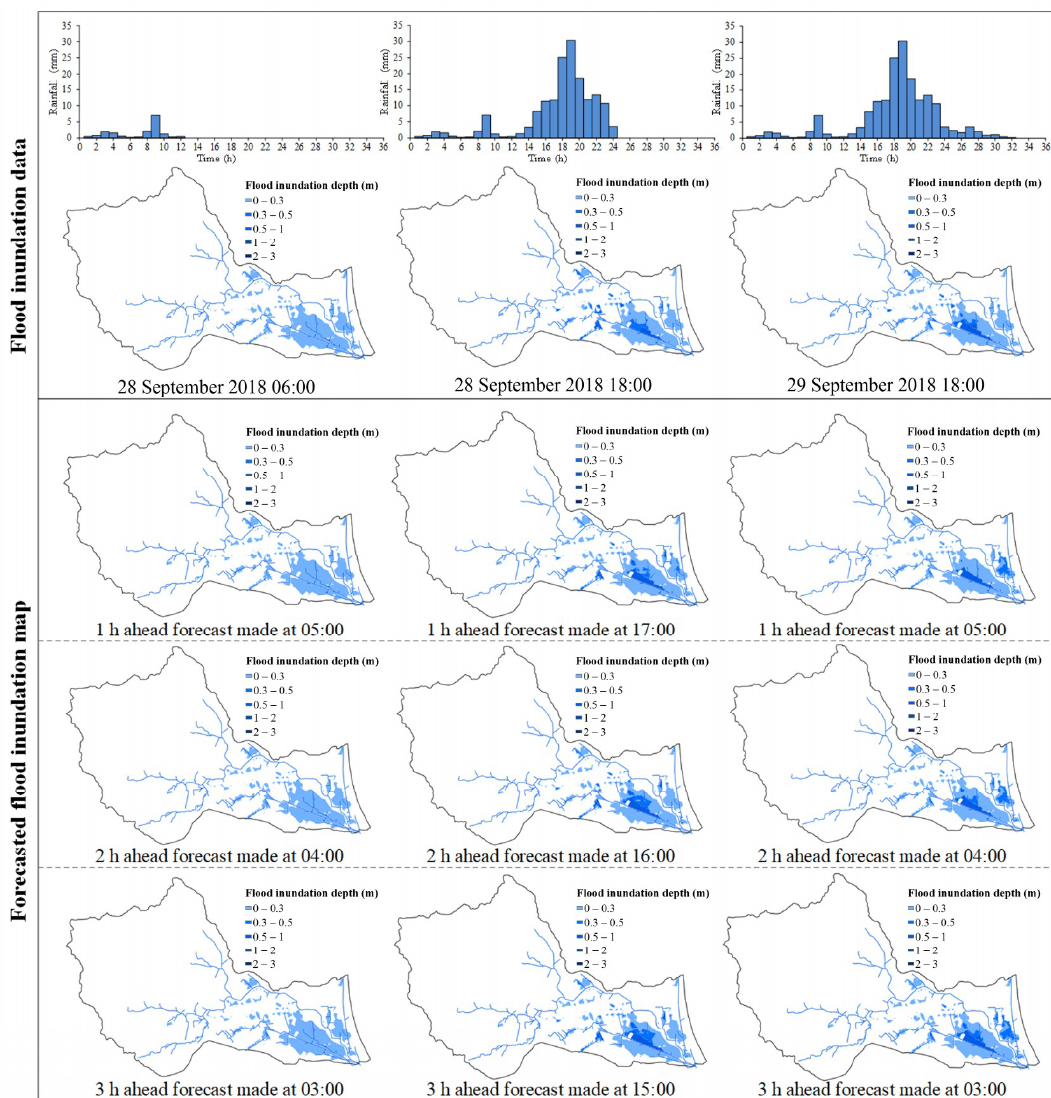
Figure 10. Comparison of flood inundation data with forecasts obtained from the proposed model for Typhoon Dujuan.